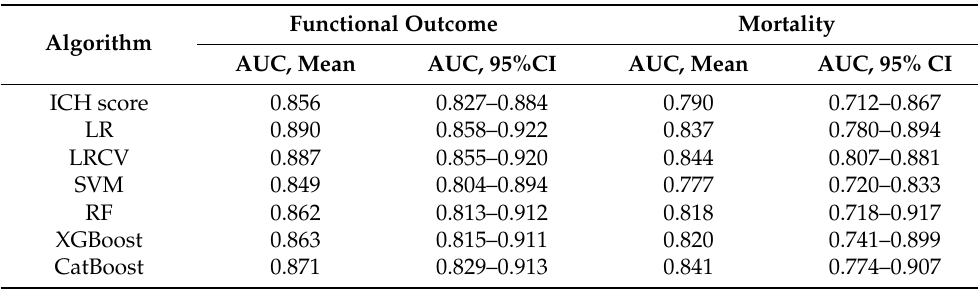
Table 2. Predictive performance for the 90-day functional outcome and mortality after spontaneous Figure 2. The receiver operating characteristic (ROC) curve of all the six machine learning (ML)- intracerebral based models compared with the traditional ICH Score, with respect to predictive performance for the functional outcome at the third month.